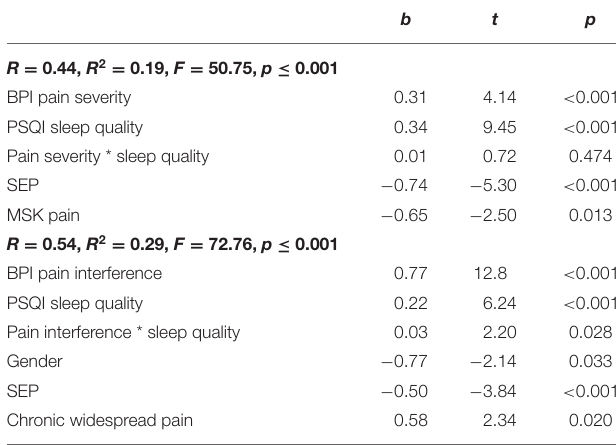
TABLE 2 | Means, standard deviations, and minimum to maximum scores for all variables.